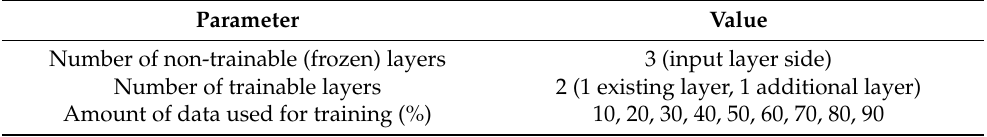
Table 5. Transfer learning model architecture. Parameter Value Number of non-trainable (frozen) layers